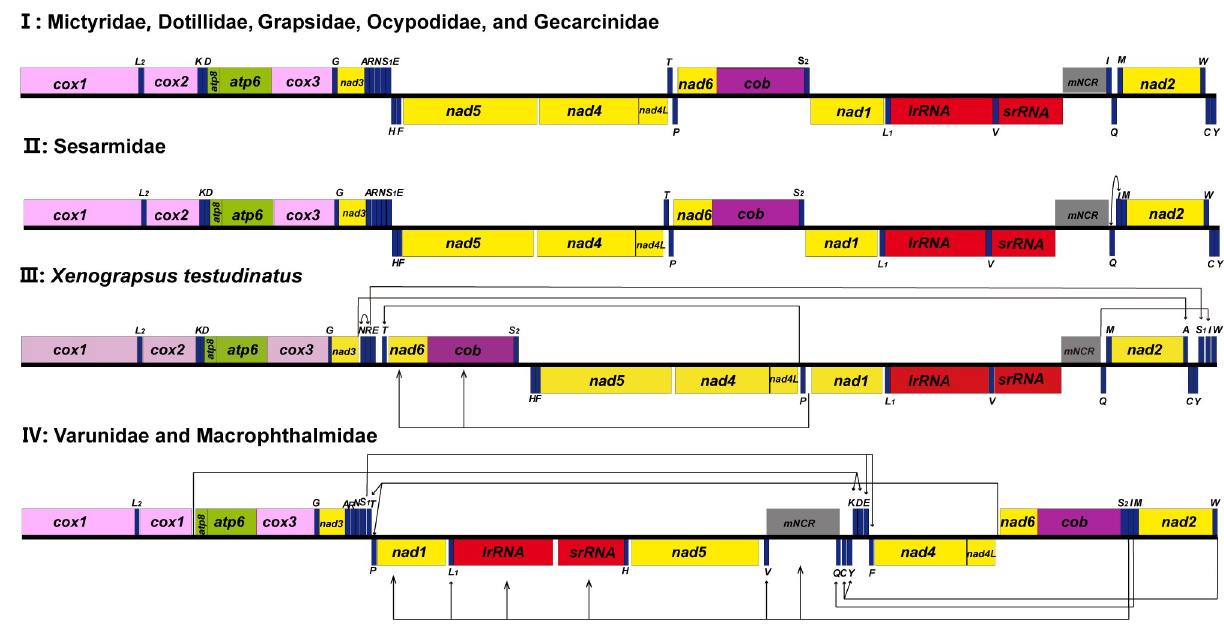
Fig 4. Gene rearrangements within the Grapsoidea and Ocypodoidea. Linear representation of the four patterns of gene rearrangements (I–IV). The transposition routes of the gene rearrangements are marked by lines and arrows.